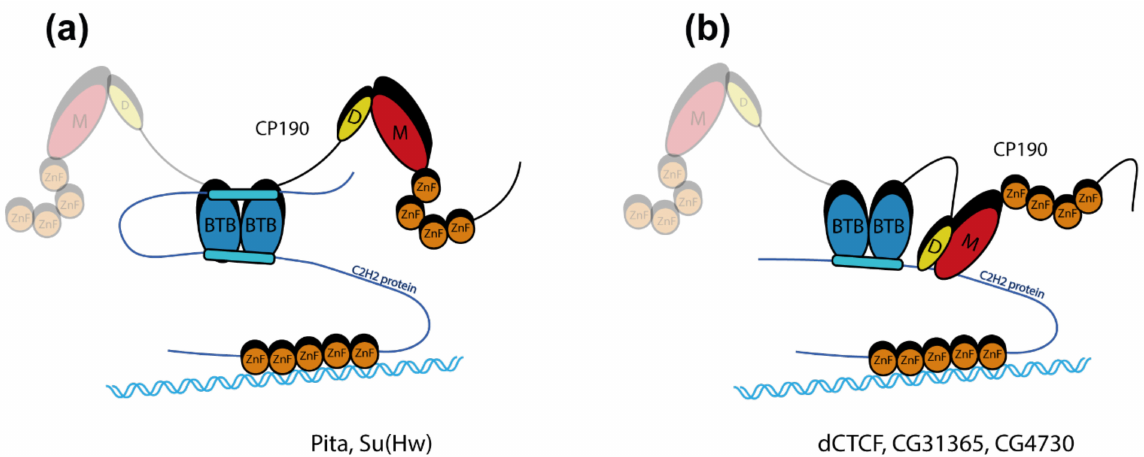
Figure 5. Schematic representation of models describing the specificity of CP190 interactions with C2H2 proteins. ( a ) The model of CP190 interaction with the Su(Hw) and Pita proteins, in which two regions additively interact with the BTB domain. ( b ) The model of CP190 interaction with proteins that interact simultaneously with the BTB and D/M domains of CP190 (dCTCF, CG31365, and CG4730). The second subunit of CP190 dimer except the BTB domain is shown as